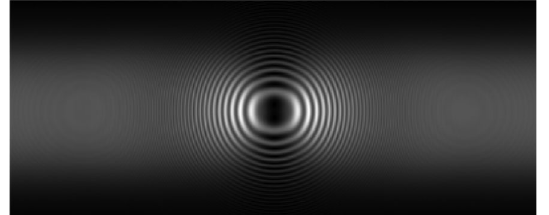
FIG. 11. Two-dimensional far field angular distribution OSRI formed by the interference of OSR from dipoles 2 and 3 by a single electron with energy 286